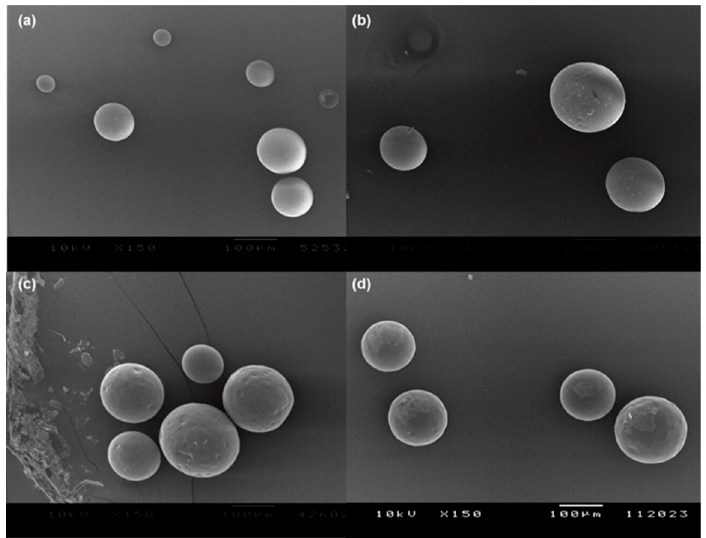
Figure 3. SEM micrographs of PLGA microspheres containing various amounts of progesterone. The actual drug payload was ( a ) 13.1%, ( b ) 20.7%, ( c ) 27.4%, or ( d ) 32.8%. The size bar is 100 μ m.